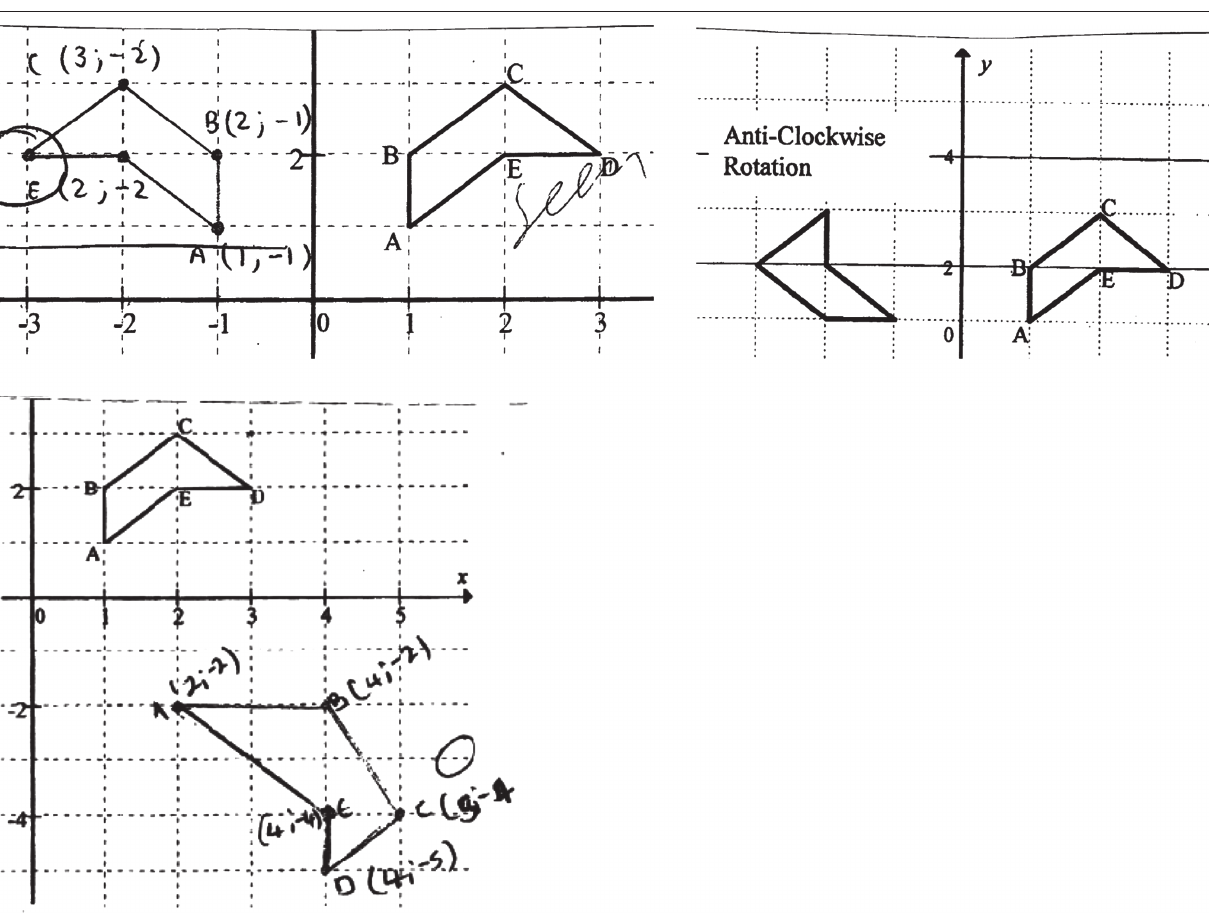
FIGURE 4: Students lack of knowledge of rigid transformation